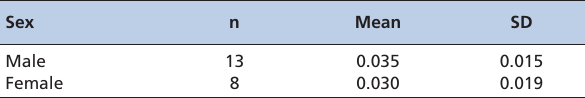
Table 1 - The number of individuals, means, and standard deviations of female and male subjects aged 3–10 years old.